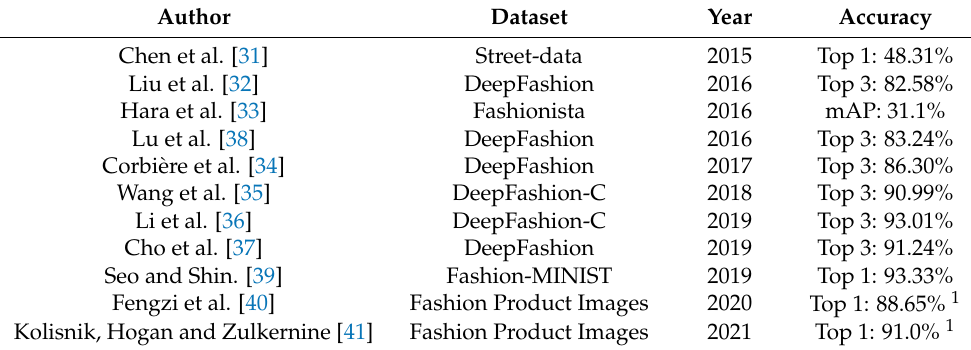
Table 1. Literature overview on fashion image classification works (adapted from